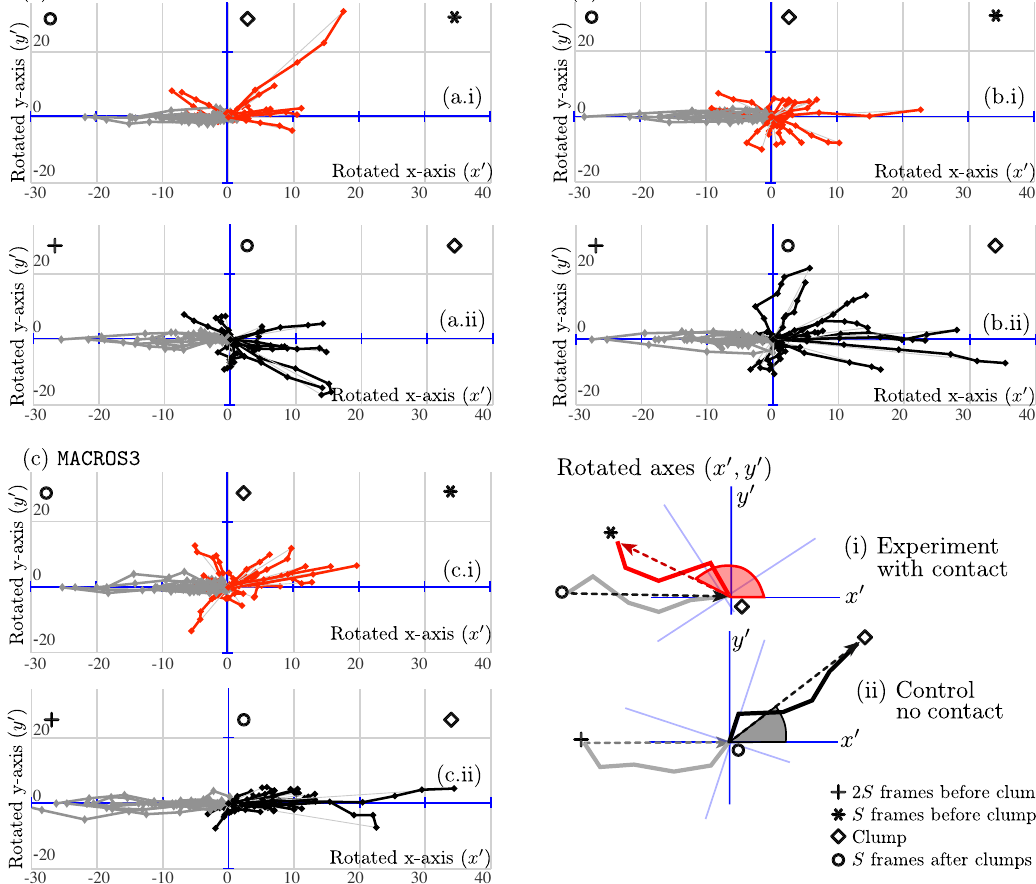
Figure 9. Comparison of the changes in track directions with or without clump interaction within the all datasets, ( a ) N = 15; ( b ) N = 17 and ( c ) N = 20. ( c ) Correspond to the results reported in [18]. The sold line represents a cell’s trajectory. Each line can be read from the utmost left point and continuing along the line. For all datasets, ( a ) MACROS1 ; ( b ) MACROS2 and ( c ) MACROS3 , (i) illustrates cells entering or exiting a clump , where the origin ( (cid:5) ) represents the clump formation. Grey lines represent S = 5 time frame points of each cell’s track before entering a clump . Red lines represent 5 time frame points of each cell’s track after exiting a clump . (ii) illustrates the movement of cells before entering a clump , where the origin ( ◦ ) represents a chosen arbitrary point (time frame